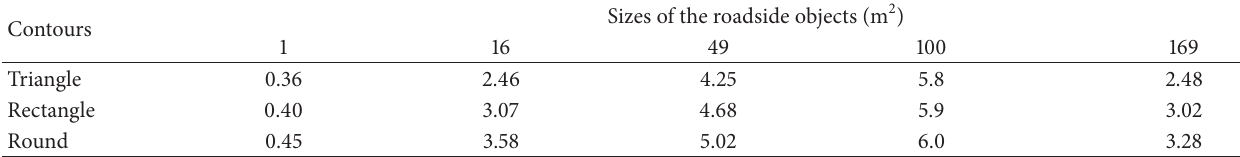
Table 8: The comfort assessment scores of the roadside objects under